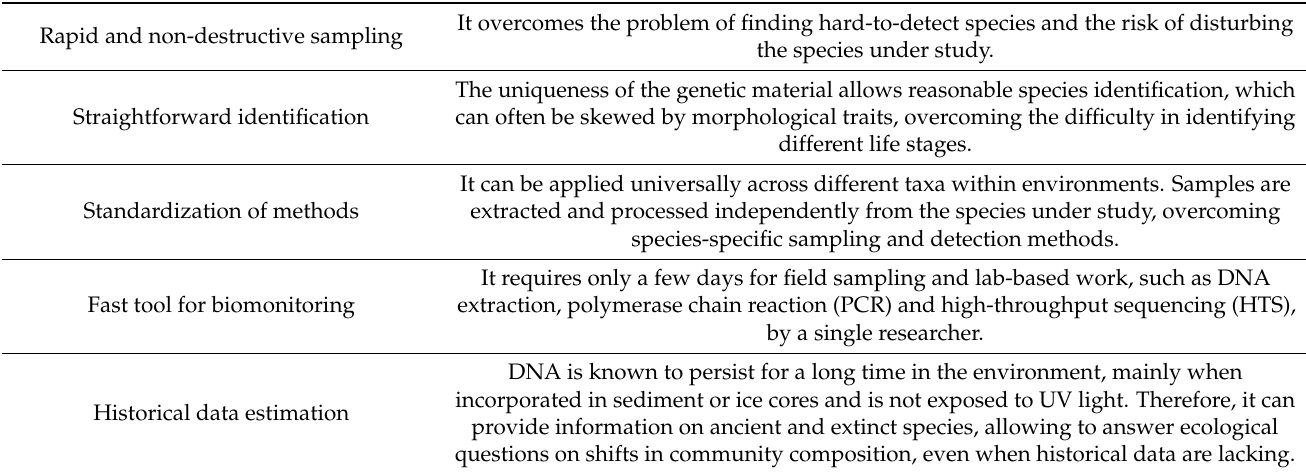
Table 6. Main advantages of eDNA metabarcoding over traditional monitoring